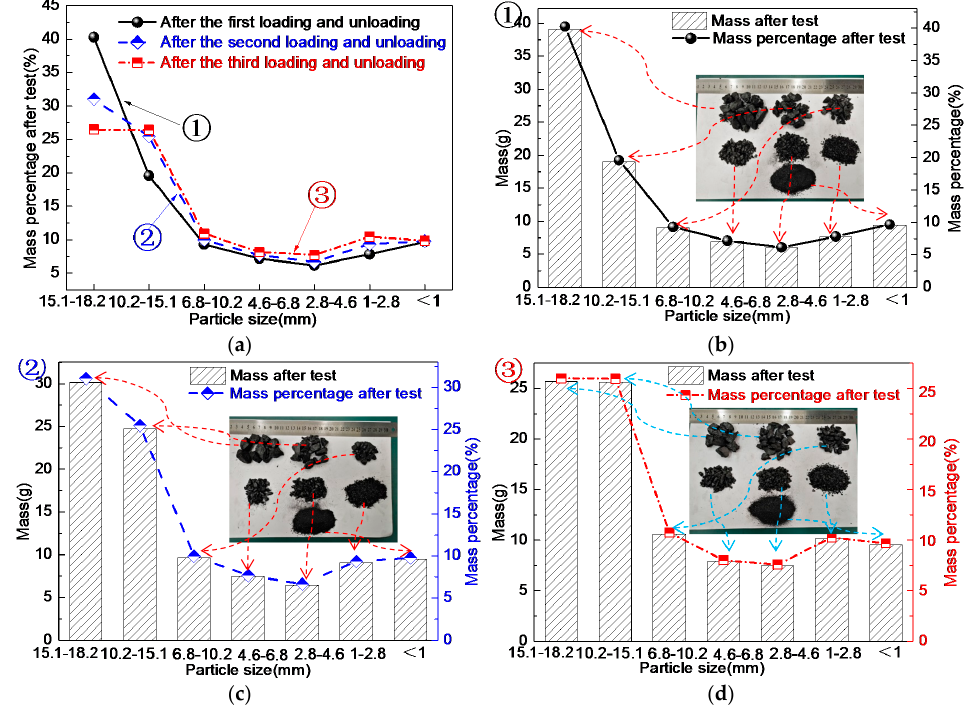
Figure 5. Mass and mass percentage of coal samples with different particle sizes after each loading and unloading seepage test: ( a ) mass percentage of coal samples with different particle sizes after each loading and unloading seepage test, ( b ) mass and mass percentage of coal samples with different particle sizes after the first loading and unloading seepage test, ( c ) mass and mass percentage of coal samples with different particle sizes after the second loading and unloading seepage test, ( d ) mass and mass percentage of coal samples with different particle sizes after the third loading and unloading seepage test.